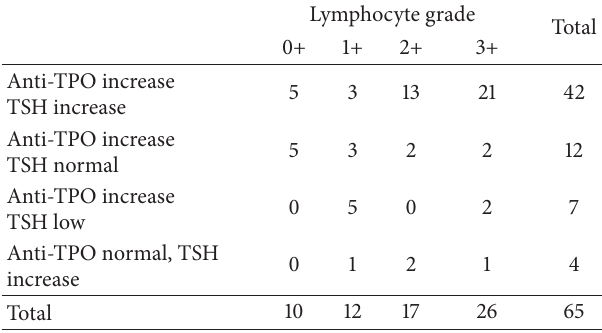
Table 2: Grading of lymphocytic thyroiditis and anti-TPO and TSH